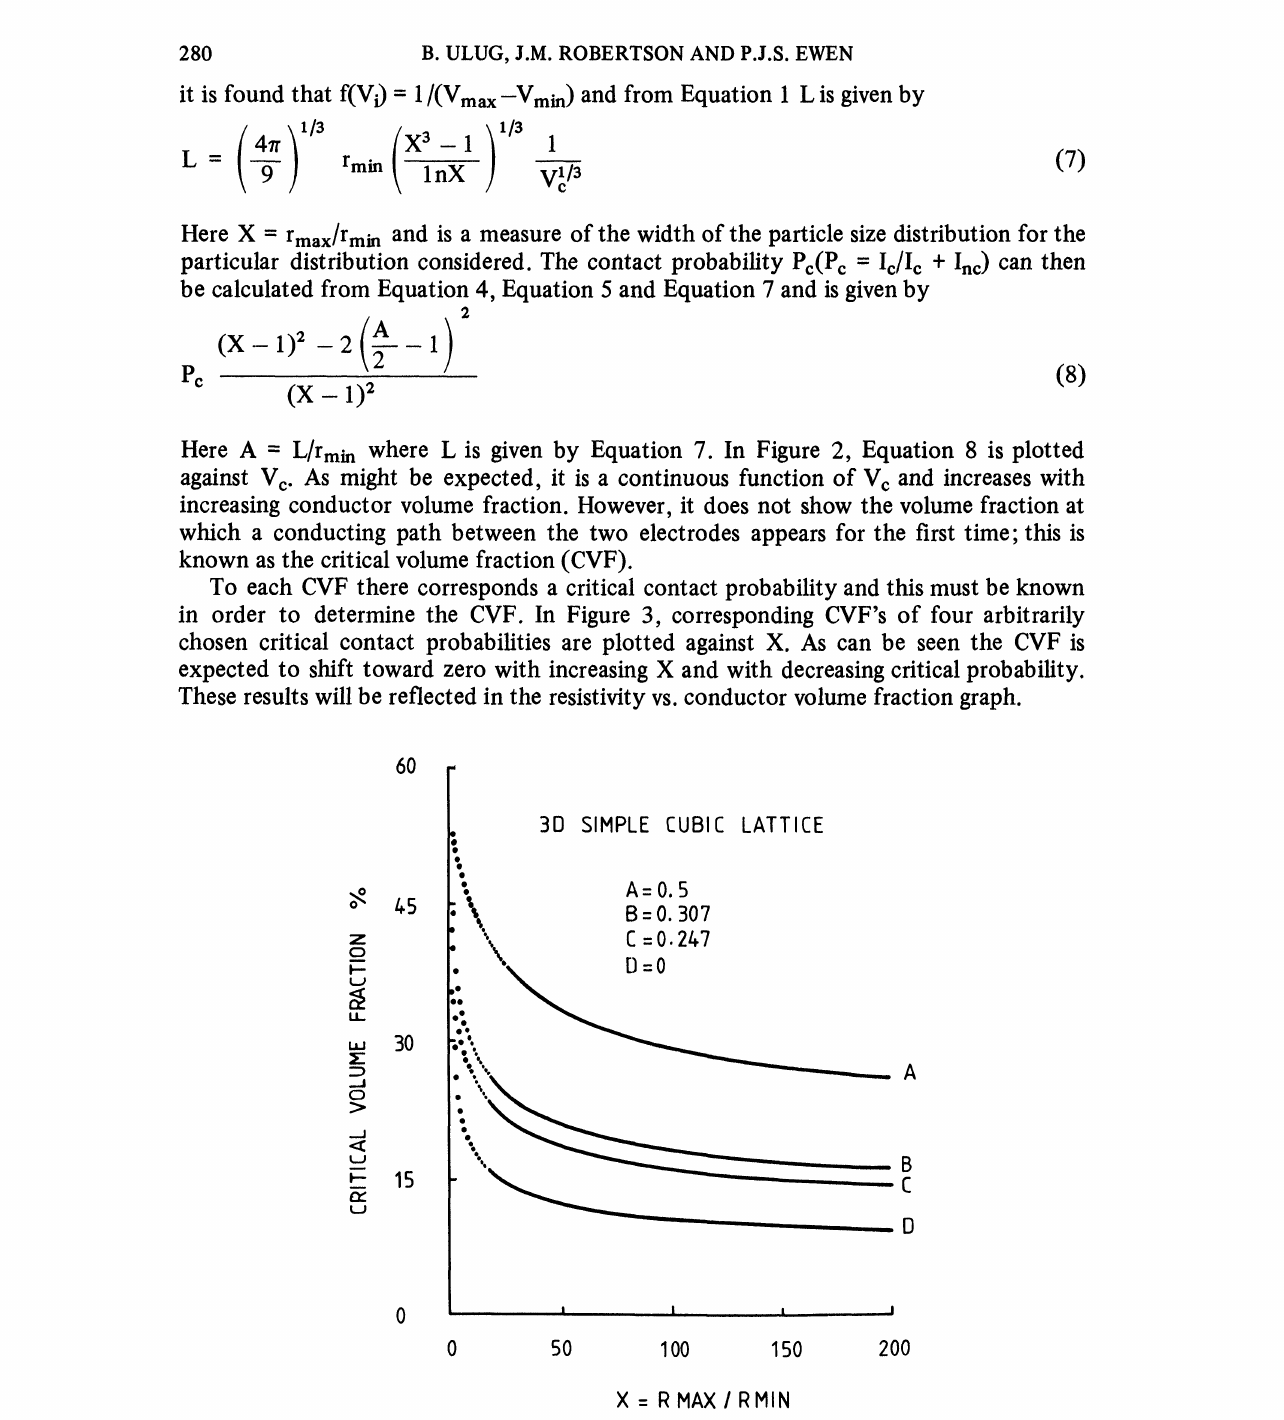
FIGURE 3 Critical volume fraction vs. X for four critical contact probabilities for f(vi) const, 3D.